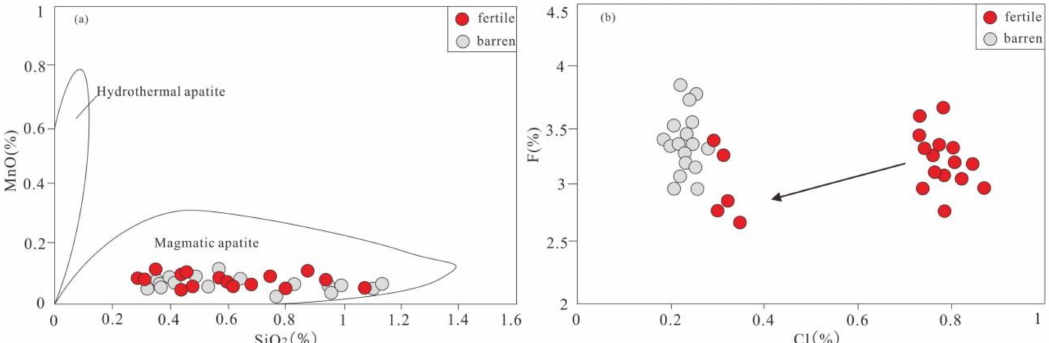
Figure 4. ( a ) Apatite genesis diagram, plots of SiO 2 versus MnO [66]; ( b ) Cl versus F in apatite, high Cl content and large Cl variation in apatite from fertile porphyry.